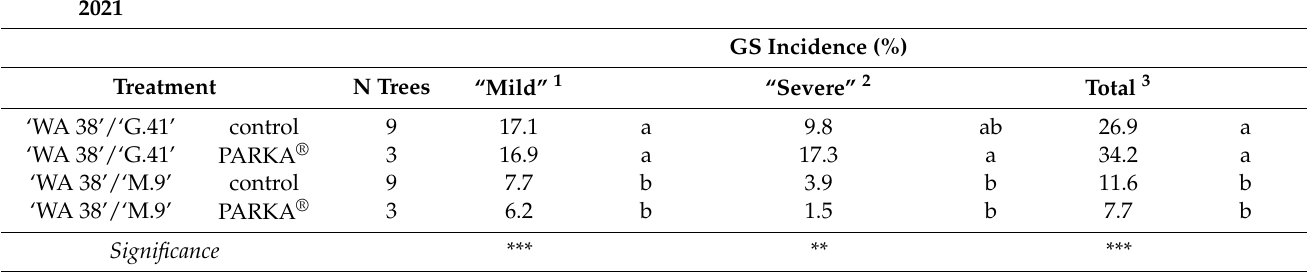
Table 3. ‘WA 38’ GS incidence (%) in 2021: comparison between apples receiving a cuticle supple- ment (Parka ® ) and apples harvested from control trees (control = no PARKA ® ) on ‘G.41’ and ‘M.9’ rootstocks. Different letters within comparisons indicate statistical differences between means for